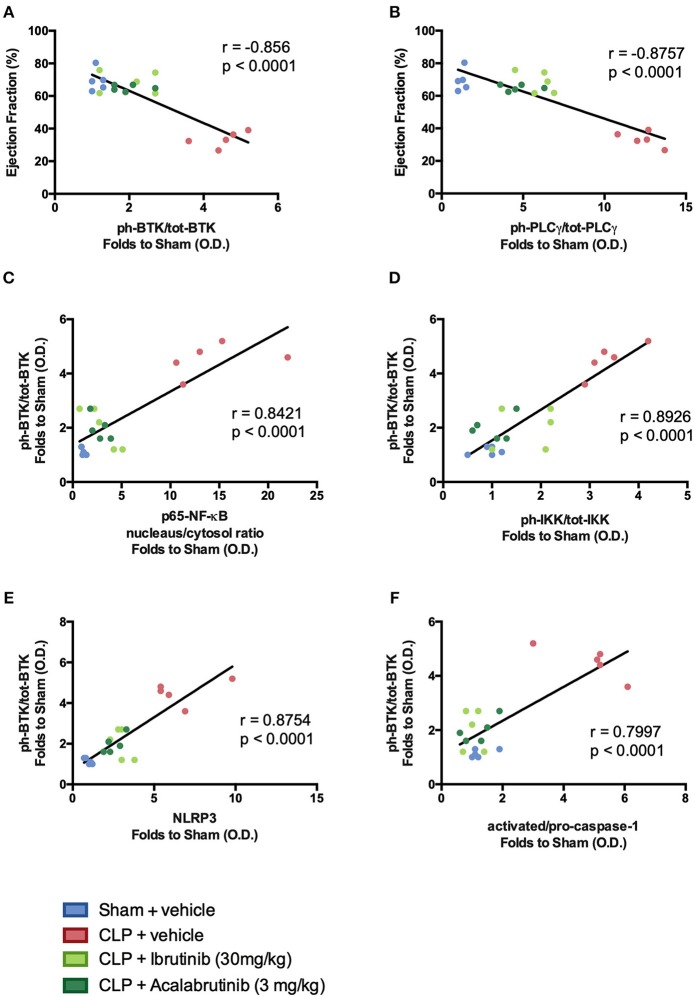
Relationship between BTK activation and cardiac dysfunction in CLP-sepsis. Correlation data to show (A) ejection fraction (%) vs. phosphorylation of BTK at Tyr223. (B) ejection fraction (%) vs. of PLCγ at Tyr1217. (C) Phosphorylation of BTK at Tyr223 vs. NF-κB p65. (D) Phosphorylation of BTK at Tyr223 vs. phosphorylation of IKKα/β atSer176/180. (E) Phosphorylation of BTK at Tyr223 vs. NLRP3. (F) Phosphorylation of BTK at Tyr223 vs. activated/pro-caspase-1. Data was analyzed by the Pearson correlation coefficient test to calculate the r value and a two tailed T-test for significance.